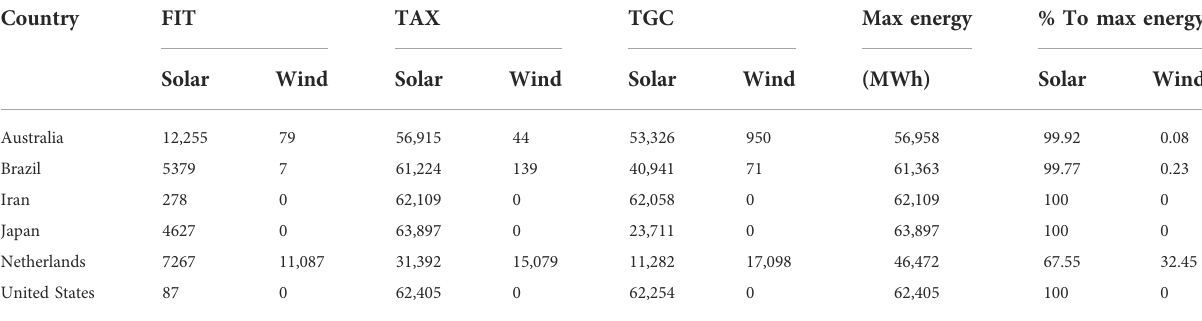
TABLE 8 Amount of generated RE in each country. Country